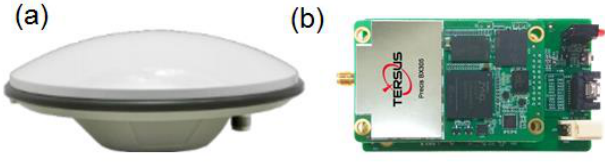
Fig. 6. Single frequency equipments used in the experiment; (a) antenna Jinchang JCA228, (b) receiver Ublox M8T receiver